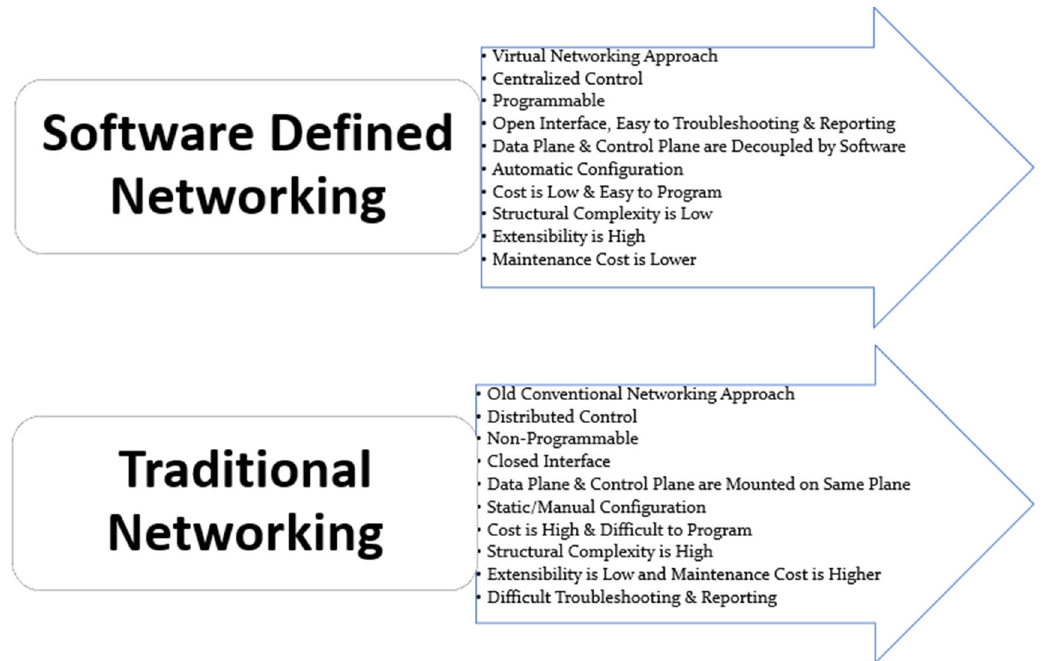
Figure 2. Differences between Software Defined Networking and Traditional Networking.